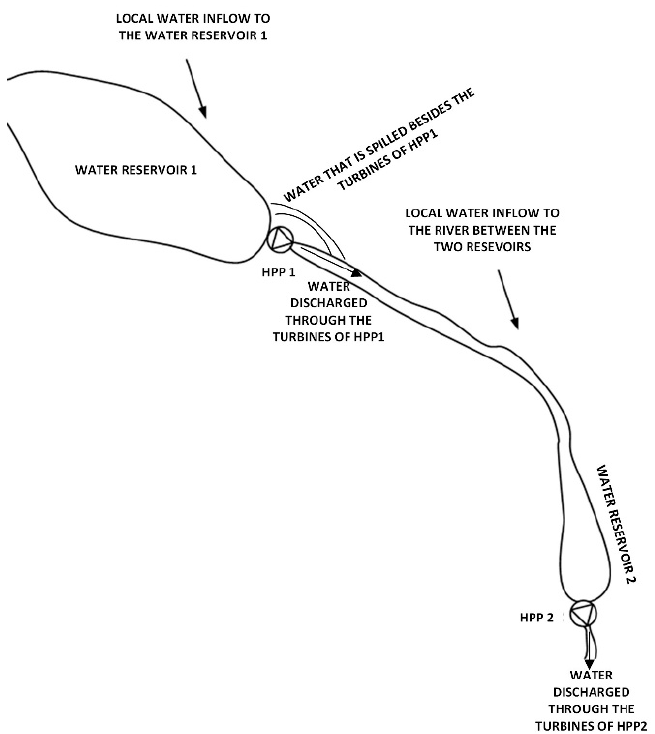
Figure 2. Relationships between two cascaded hydropower plants (HPPs).